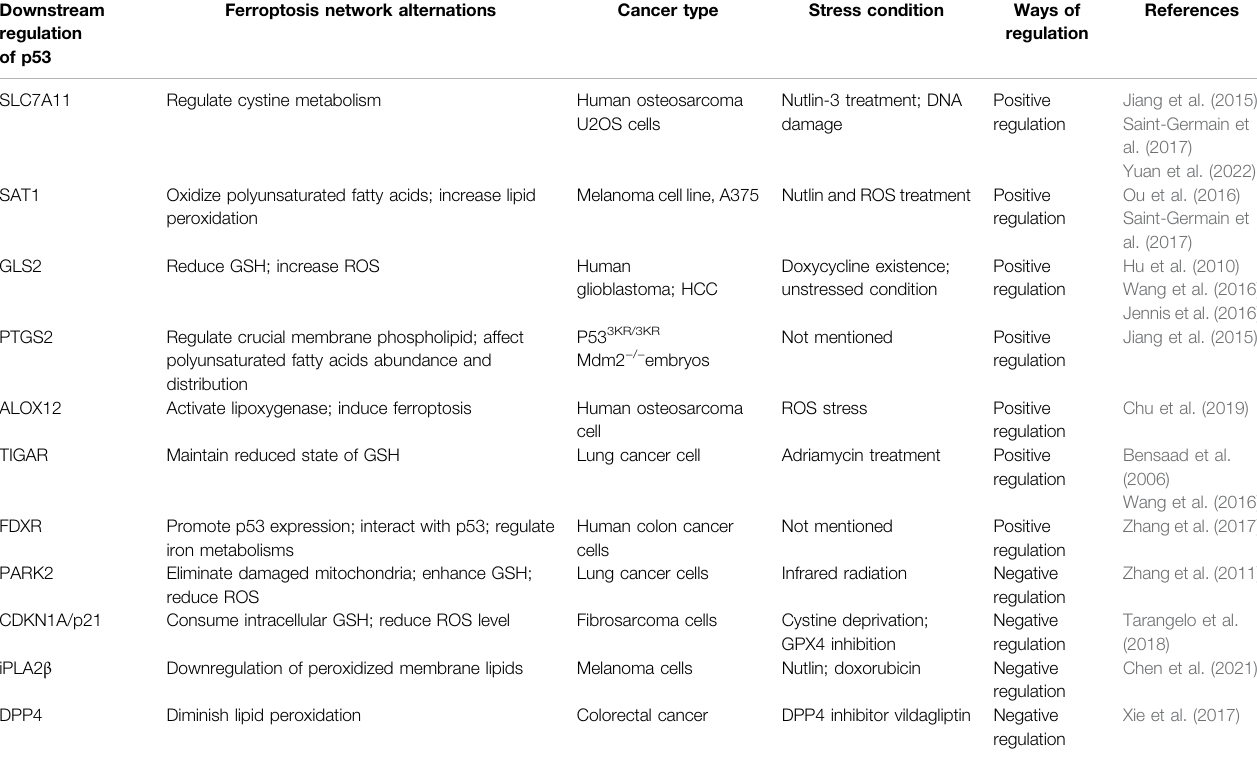
TABLE 1 | Regulation of p53 in ferroptosis